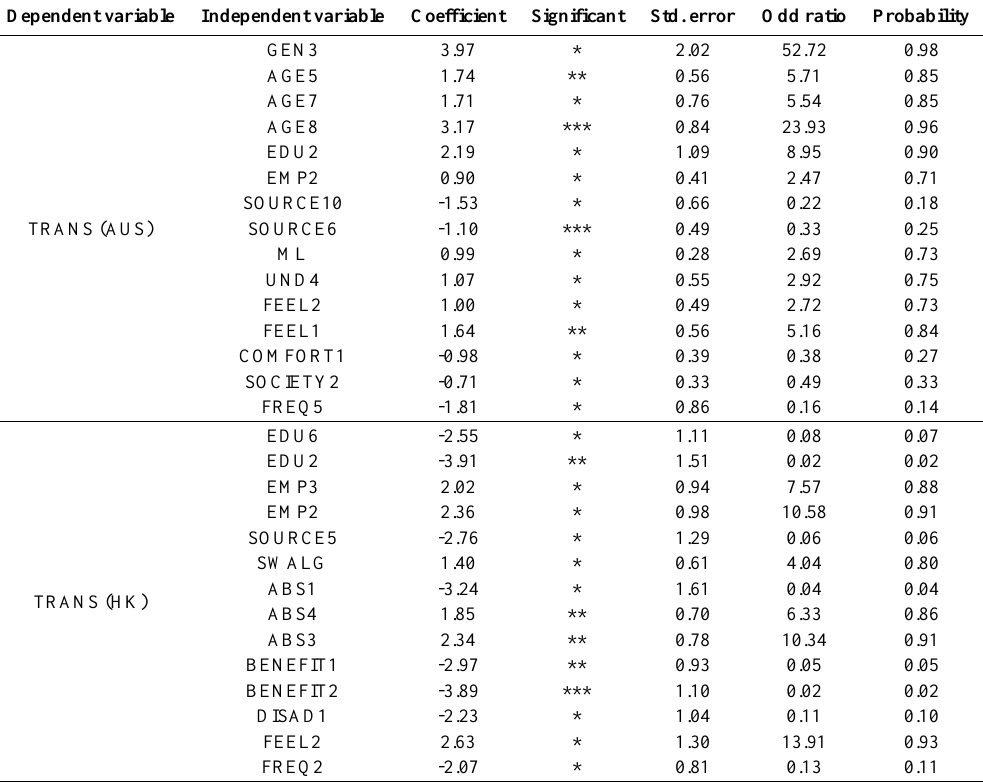
Table A-16. Transport management